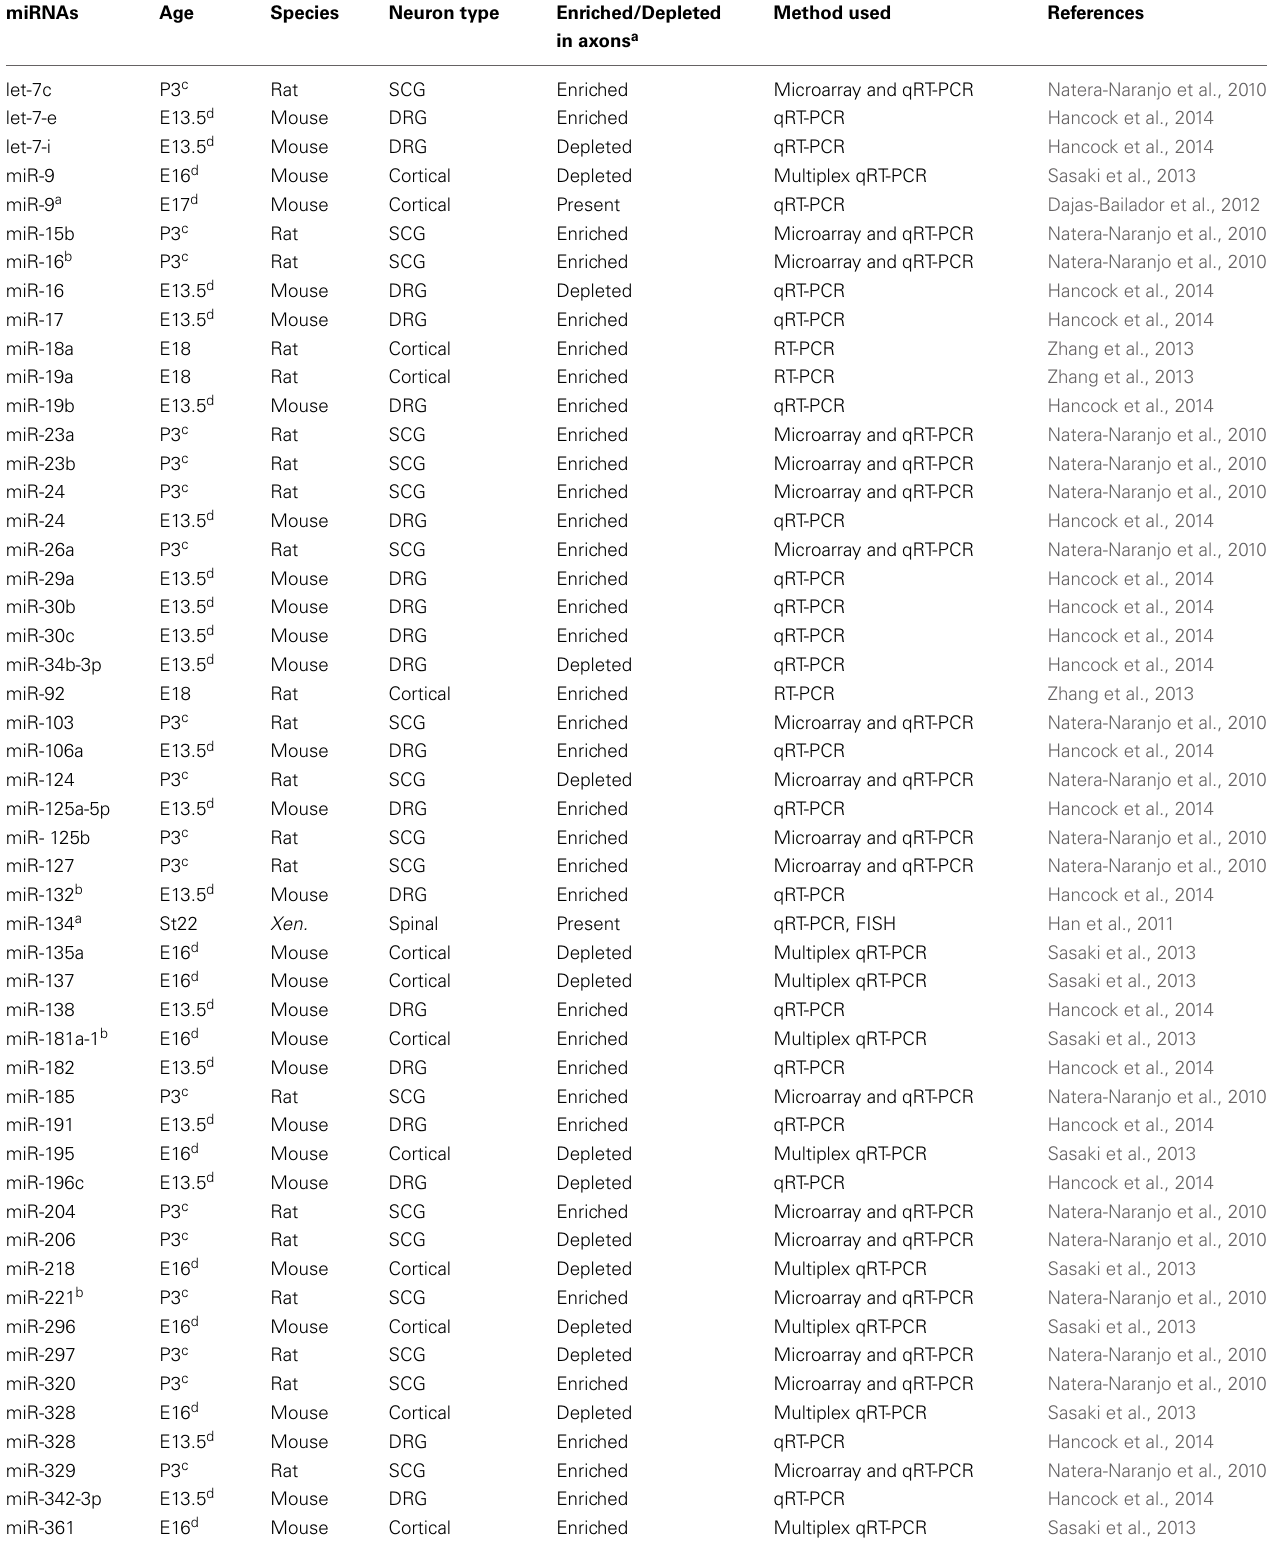
Table 2 | List of miRNAs enriched or depleted in axons, or present in growth cones during axon development.